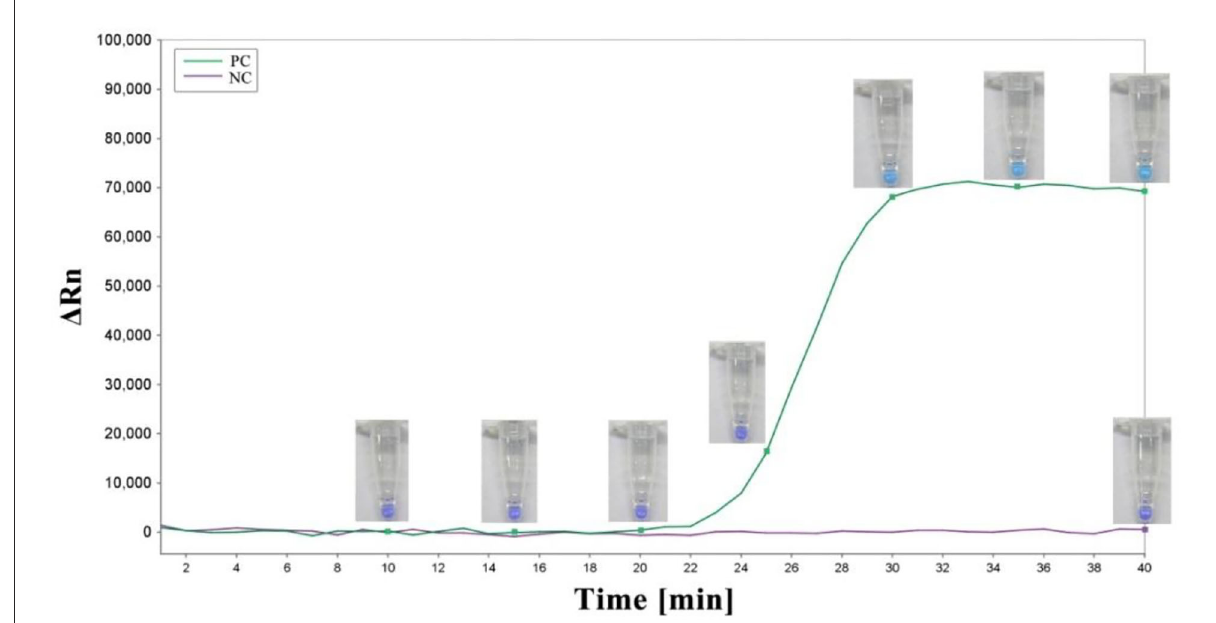
FIGURE4 The amplification plot and corresponding colors of the LAMP mixture over time. A sky blue color was observed in the case of amplification, whereas the negative control remained violet after the reaction. PC, positive control; NC, negative control.